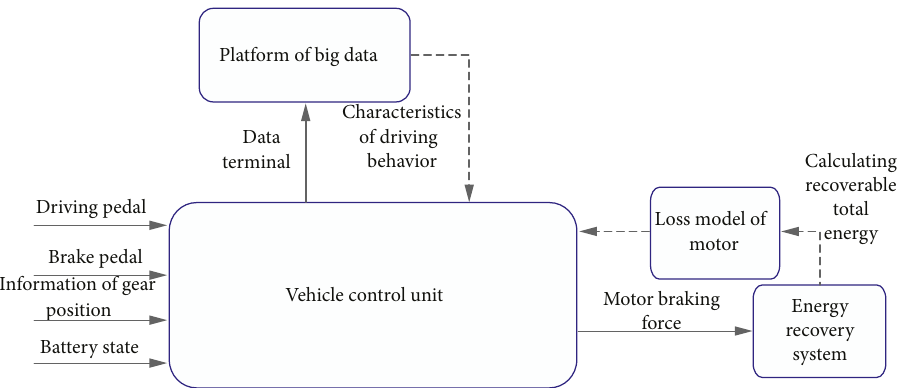
Figure 1: Energy recovery system based on big data and motor loss